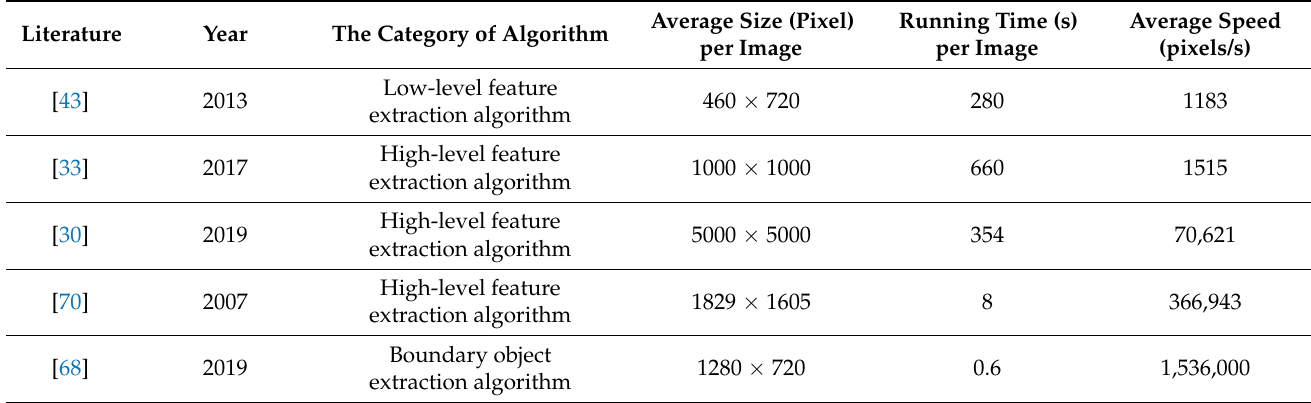
Table 14. Calculation speeds of algorithms.